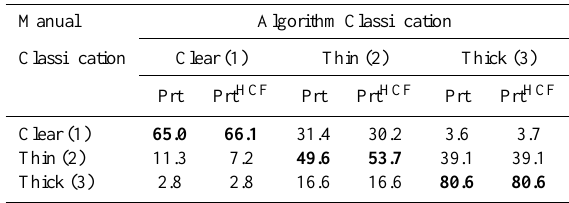
Table 3. Confusion matrix for CDOC of training set based on the Prt metric (Eqs. 7, 8 respectively). All values are in